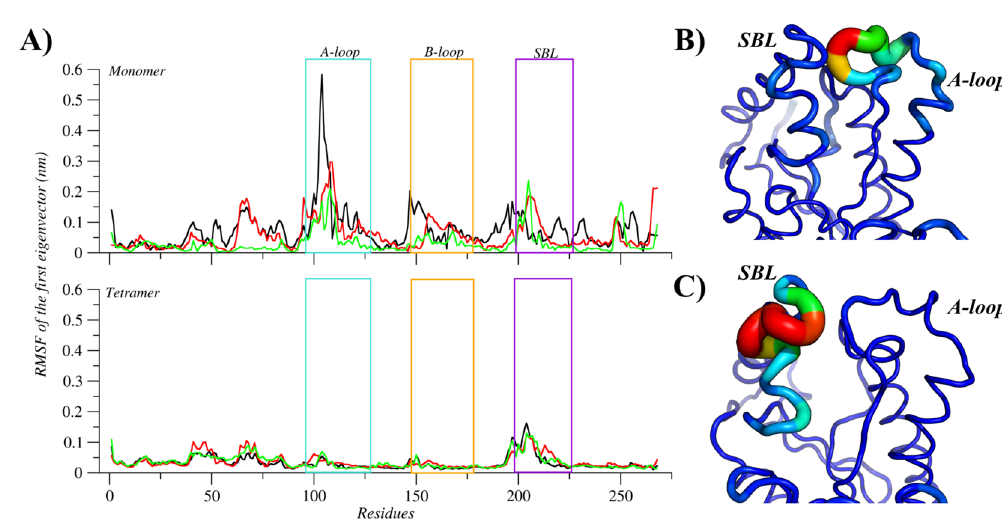
Figure 3. Flexibility of the apo MtInhA. ( A ) Root mean of the root mean square fluctuation (RMSF) for the monomeric and tetrameric systems, according to the first eigenvector. The regions A-loop, B-loo, and SBL are highlighted with boxes and coloured in light blue, orange, and purple, respectively. In addition, black, red and green lines represent the three simulations’ repetitions. The mobility and conformation change of the most representative structure extracted from the MD trajectories for monomer ( B ) and tetramer ( C ). The thickness is proportional to B-factor values. Image generated with XMGrace 38 and PyMOL 36